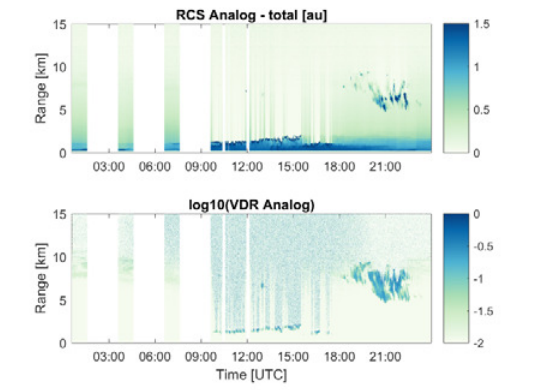
Figure 5. RCS (upper) and VDR (middle) at East Malling on 26/05/2016 during a biomass burning event